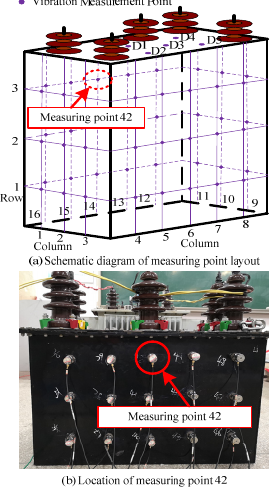
Figure 7. Measuring point layout.